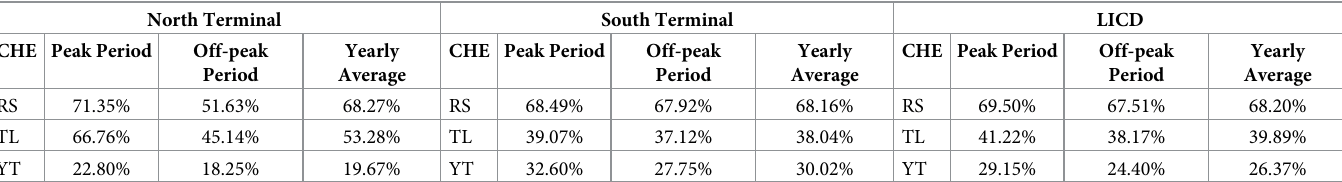
Table 9. Simulation results for scenario S3.